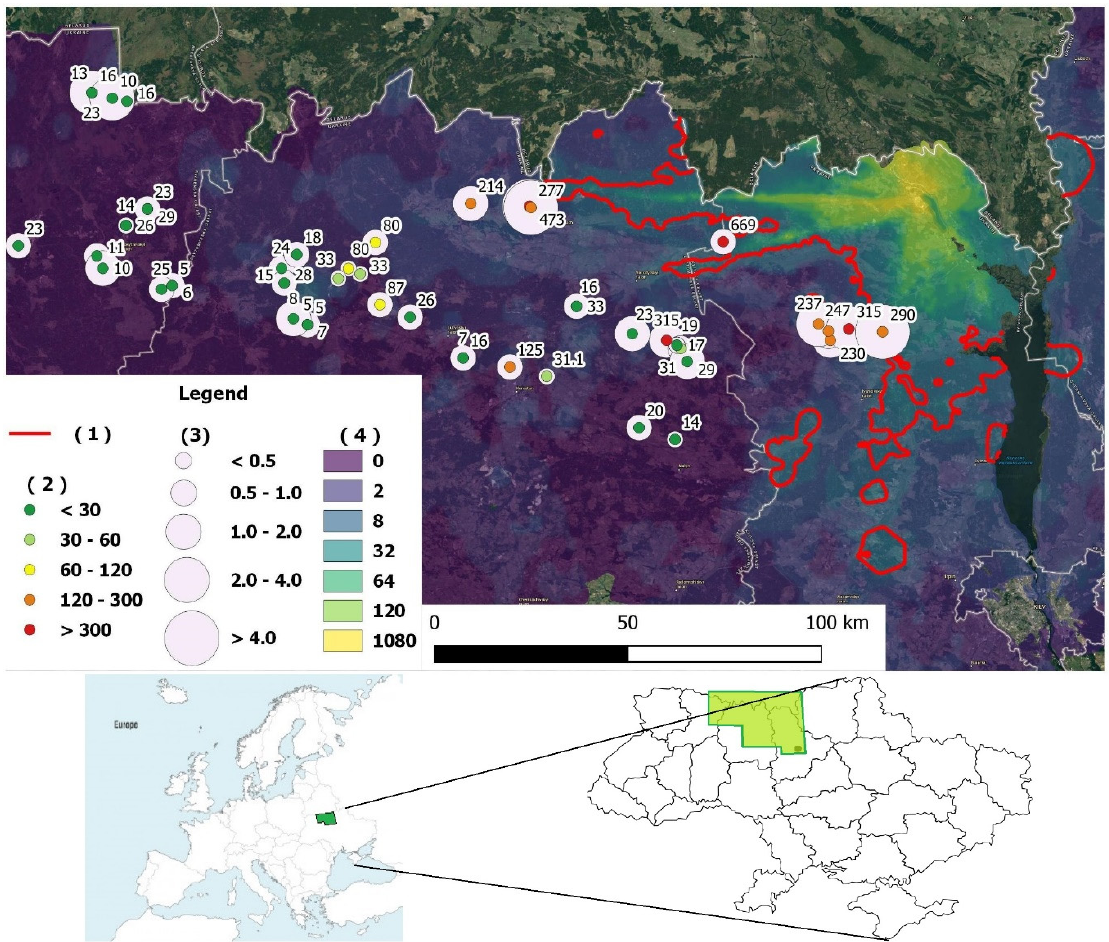
Figure 6. 90 Sr contamination density of soil and sampling points for stem wood and soil within forest stands: 1 —border of territories with contamination of stem wood > 60 Bq · kg − 1 at P = 50%; 2 — 90 Sr activity concentration of stem wood from sampling point (with 90 Sr activity concentration values on the map), Bq · kg − 1 ; 3 — 90 Sr contamination density of soil from sampling point, kBq · m − 2 ; 4 — 90 Sr contamination density of soil, kBq · m − 2 . Note: Google Maps and Environmental Systems Research Institute (ESRI) Boundaries and Place are a background of the